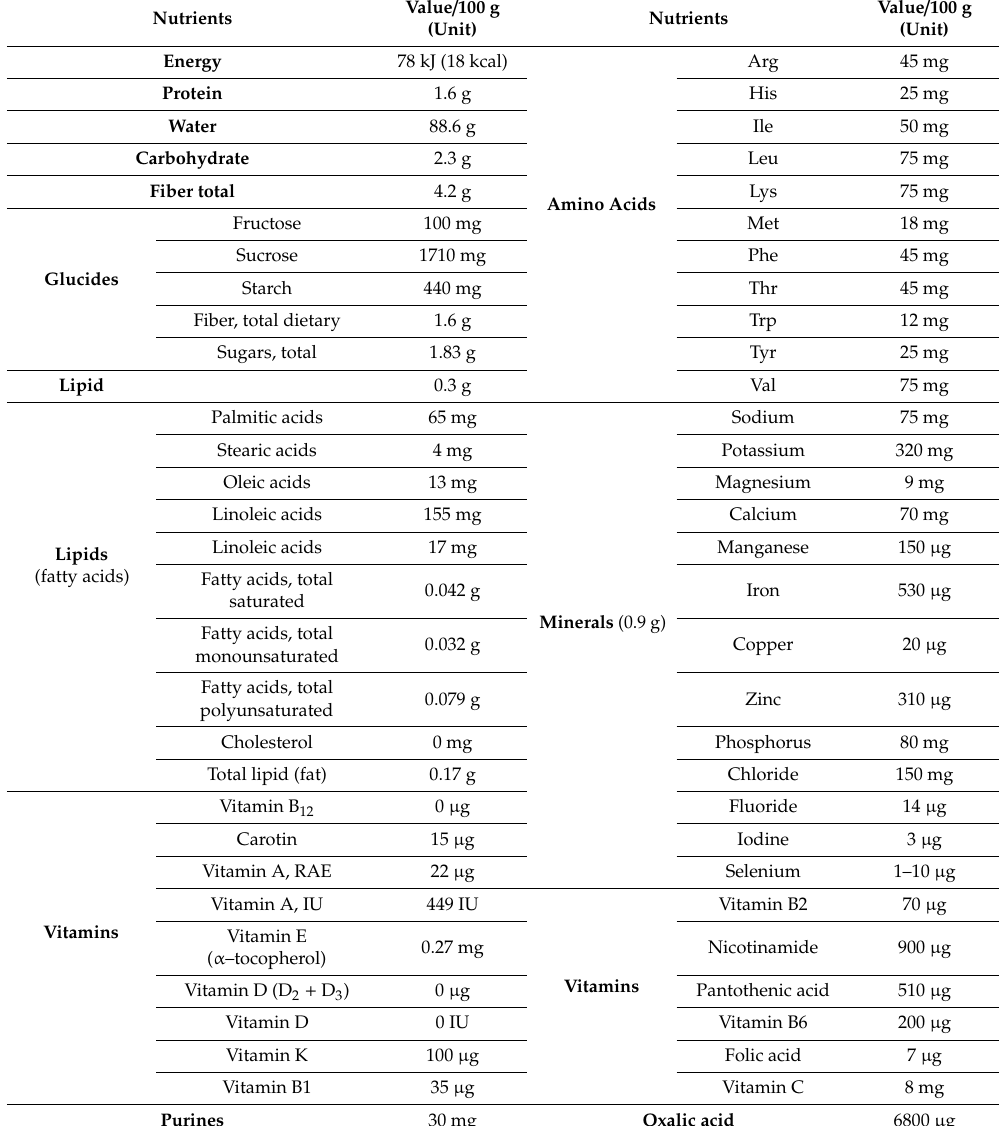
Table 1. Nutritional value per 100 g Apium plants [adapted after http: // ndb.nal.usda.gov / ndb / foods].